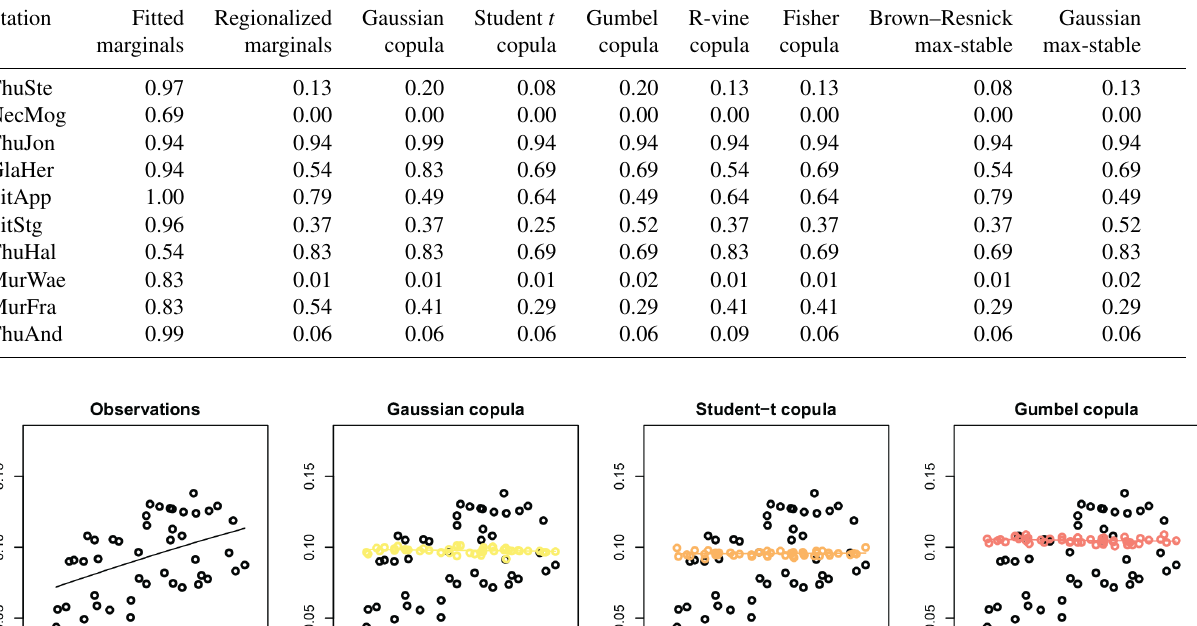
Table 3. p -values for all stations obtained when comparing two samples, observations, and simulations, using the Kolmogorov–Smirnov test. The name of the simulated dataset is indicated in the column name. Note that the p -values are not adjusted for multiple testing.